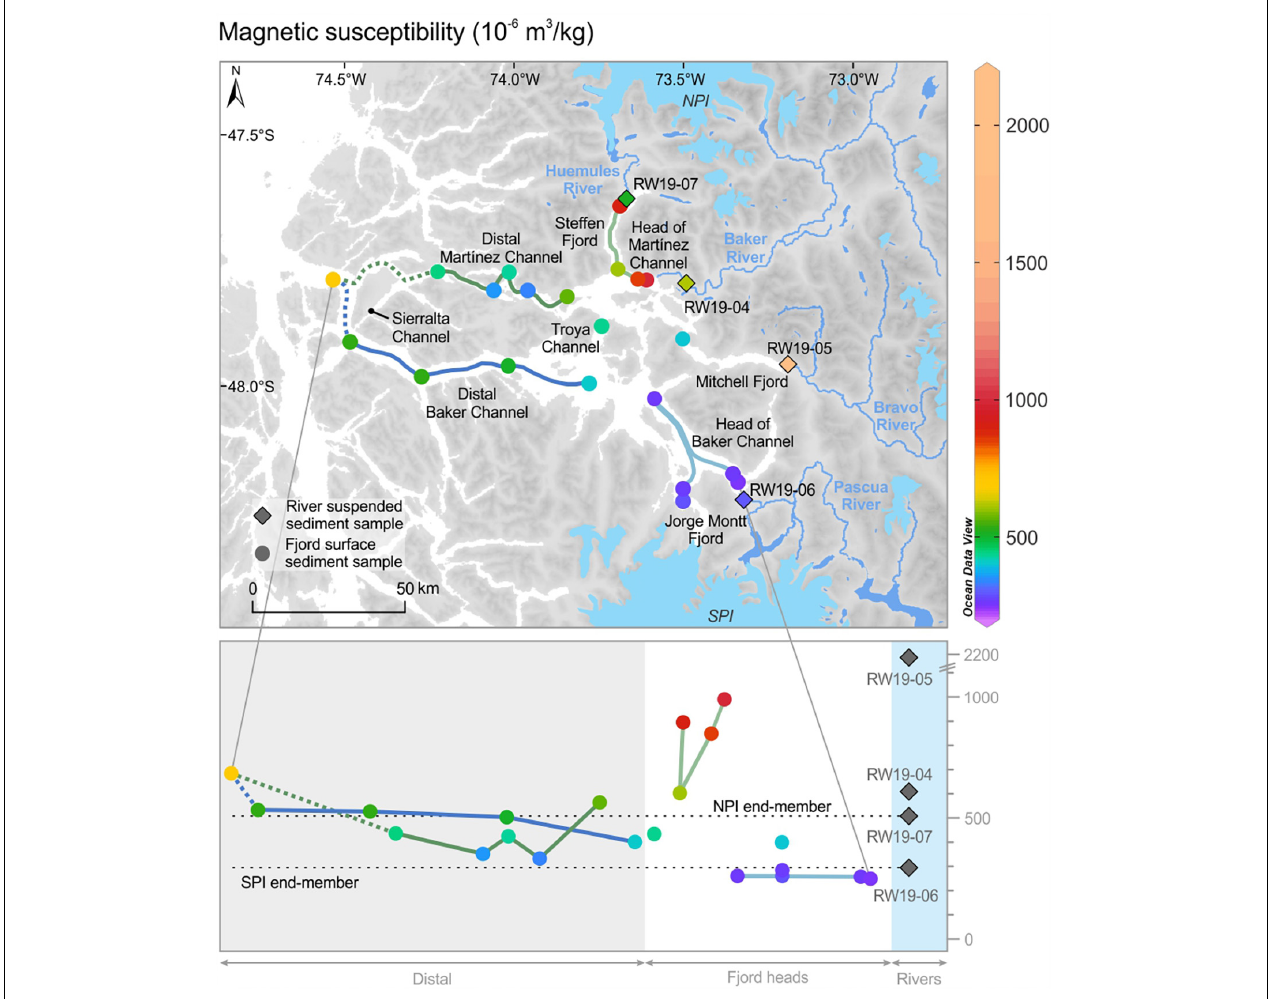
FIGURE 3 | Spatial variability in the magnetic susceptibility of the fjord and river sediment samples. The colored lines between the fjord samples represent the four subsets with n > 1 ( Figure 2 ). In the bottom panel, the fjord samples are plotted according to longitude. The provenance end-members are defined by the RW19-07 (NPI) and RW19-06 (SPI) river sediment